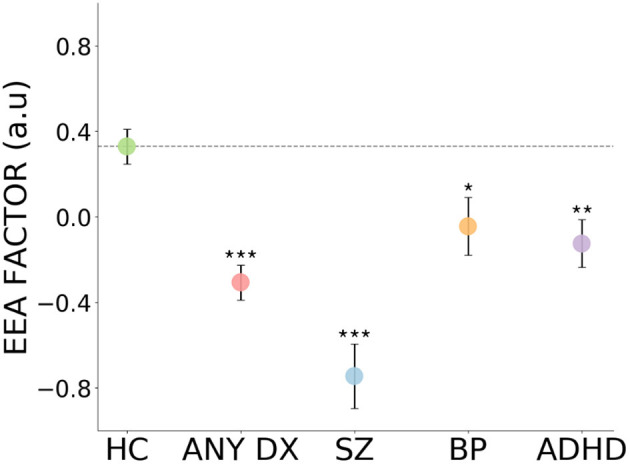
Impaired evidence accumulation across psychiatric diagnoses. The evidence accumulation factor is significantly reduced in all patients, collapsing across the three diagnoses, in comparison to healthy controls. It is also reduced in each patient groups separately in comparison to healthy controls. HC, Healthy Controls; ALL DX, All three patient groups combined; SZ, Schizophrenia; BP, Bipolar Disorder; ADHD, Attention-deficit/hyperactivity Disorder; a.u., arbitrary units. Error bars reflect represent standard error. ***p < 0.001, **p < 0.01, *p < 0.05.